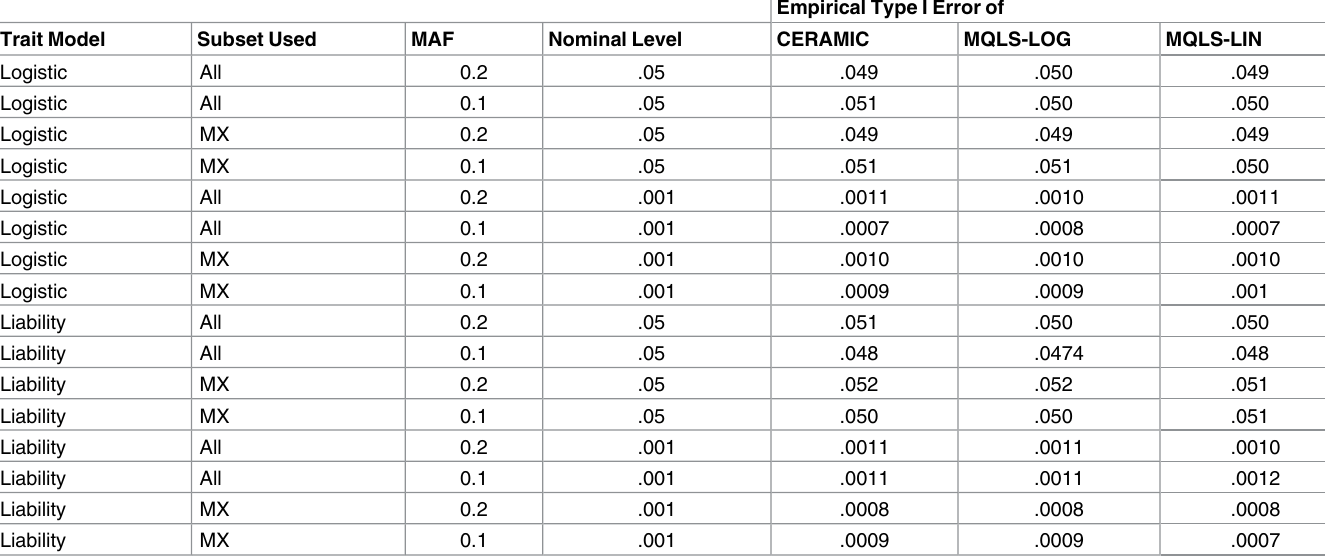
Table 2. Empirical Type 1 Error of CERAMIC, MQLS-LOG and MQLS-LIN, Based on 25,000 Simulated